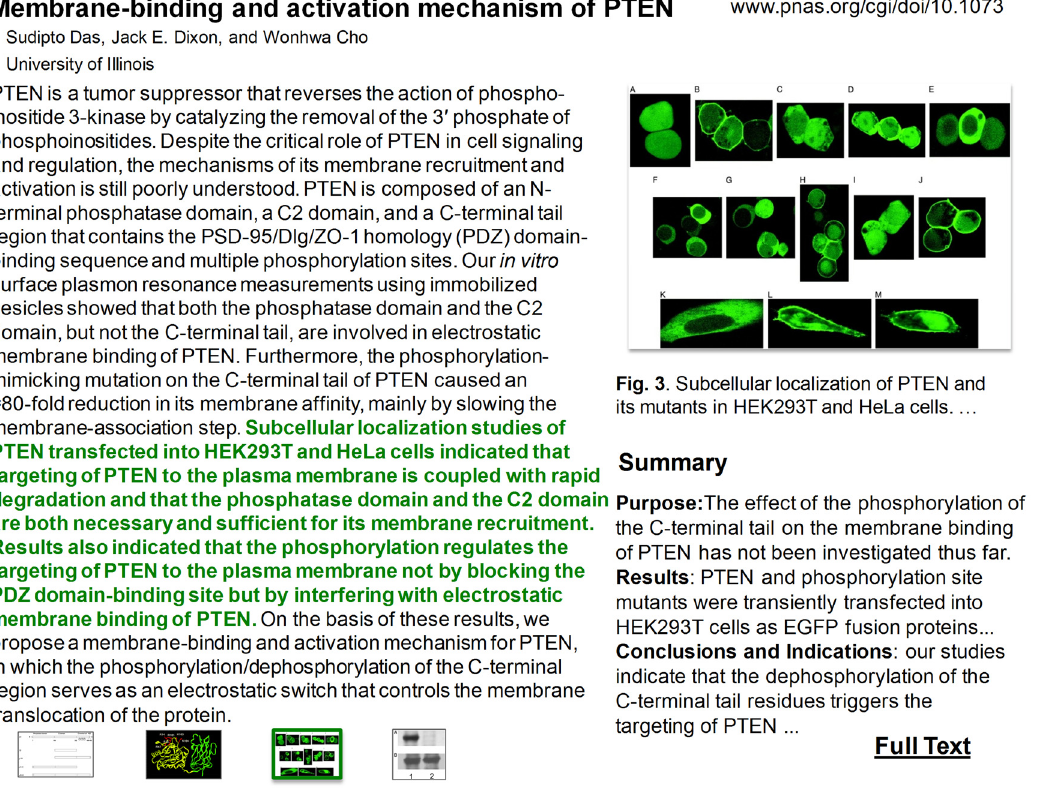
Figure 8. A novel user interface allowing efficient figure access. The user interface shows title, author, reference, abstract, and thumbnails of all figures. When the figure is shown first, the most important figure (‘‘Fig. 3’’ in this example) is enlarged and highlighted, along with its figure legend and text summary. The corresponding sentences in the abstract are also highlighted. When a user moves the mouse over any figure thumbnail, or any sentence, the corresponding figure is dynamically enlarged, replacing the previous one, and its figure legend and summary are dynamically generated. A link to the full-text article is at the bottom-right corner. doi:10.1371/journal.pone.0012983.g008 PLoS ONE |